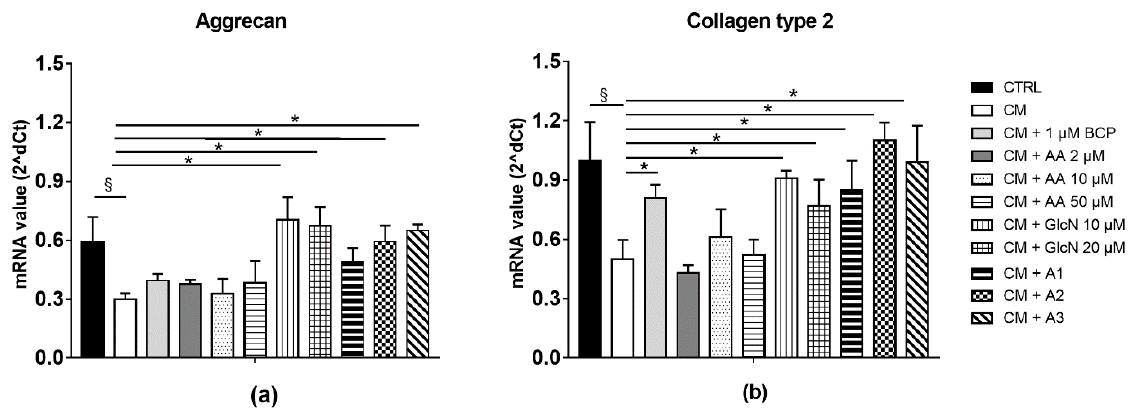
Figure 4. Aggrecan and collagen type II expression of chondrocyte cultures exposed to U937 CM in the presence or absence of BCP, AA and GlcN. Human chondrocytes exposed for 24 h to CM of activated U937 were cultured in the presence or absence of 1 µM BCP, alone or in combination with different amounts of AA and GlcN (A1, A2, A3 mixtures). RNA transcript levels specific for aggrecan ( a ) and collagen type II ( b ) were evaluated at the gene level by qPCR at 24 h after treatment. § p < 0.05 CM vs. the control and * p < 0.05 vs. CM-treated cells. Statistical differences are based on one-way ANOVA test, and data are expressed as mean ± SE obtained from three independent experiments. CM, chondrocytes cultures exposed to U937 CM.